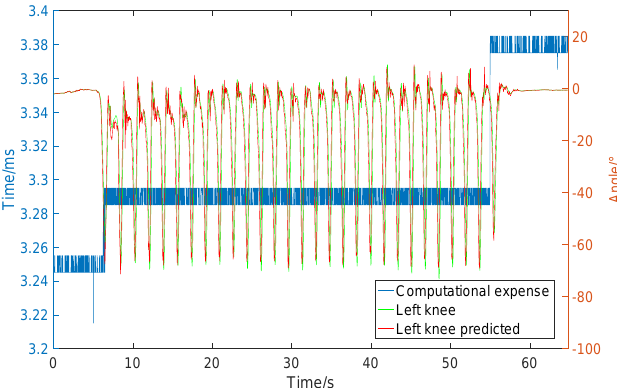
Figure 18. Real-time computational expense of the GwOc-KC-NHgo method (left hip data at 2 km/h